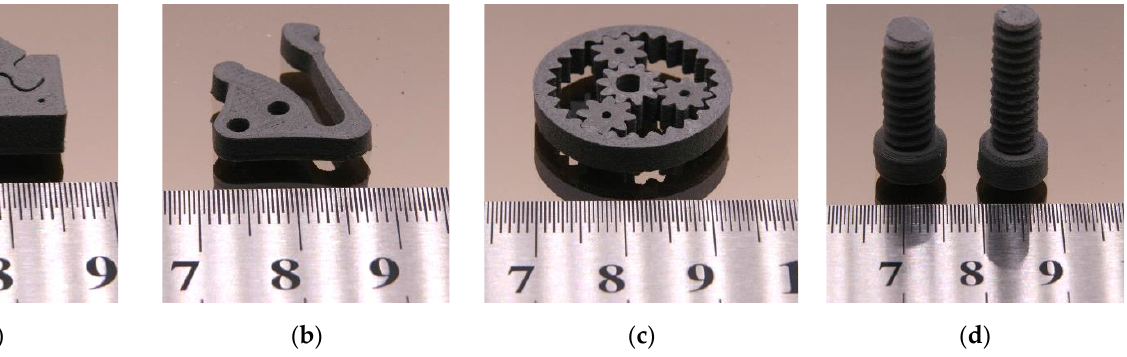
Figure 15. Printed PEG (8000)60/PMMA40 feedstock (solid load 60 vol%). ( a ) Puzzle (FFF); ( b ) test